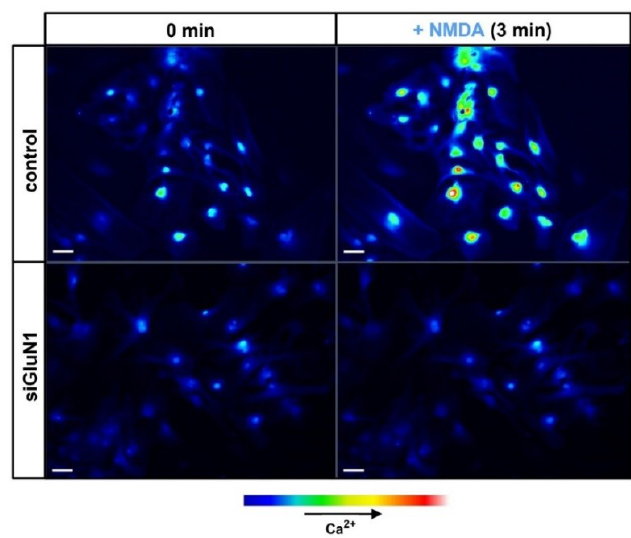
Figure 2. Confocal images of [Ca 2+ ] changes in cultured mouse astrocytes before (control) and after silencing GluN1 subunit of NMDAR (siGluN1). Silencing procedure was exactly as in Skowro´nska et al., (2019) [72]. Cells were pre-loaded with the fluorescent Ca 2+ indicator, Fluo-3-AM. The images display untreated cells (0 min, left) and cells treated with 100 µ M NMDA (3 min, right). The strength of the [Ca 2+ ] signal is expressed by the relative intensity of Fluo-3-AM fluorescence in a pseudo-color scale (bottom: pseudo-color bar). Scale bars, 50 µ